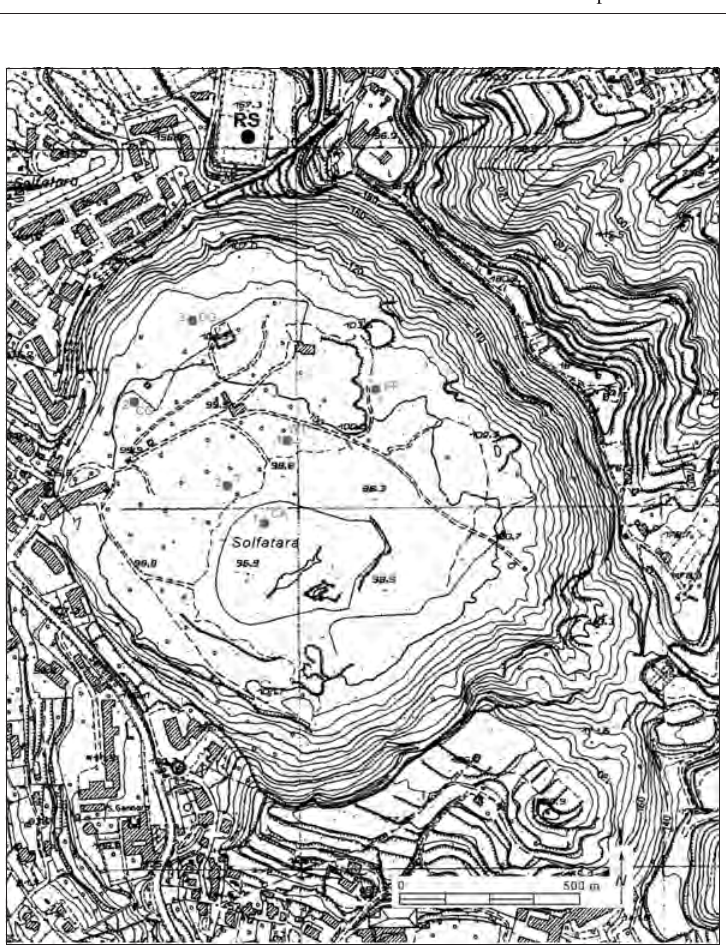
Fig. 1. Topographic map of the Solfatara crater. Gray squares indicate the surface temperature measurement sites; the black circle (RS) locates the radiosonde launch